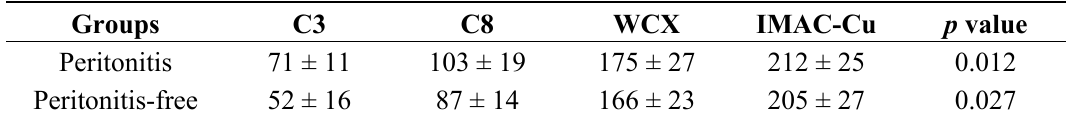
Table 1. Protein profiles obtained with various chemical affinity beads.